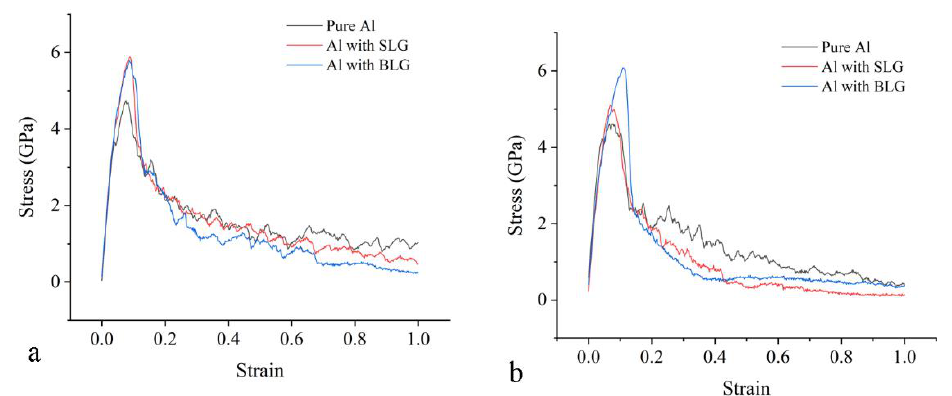
Figure 6. The atomic details of SLG in the tensile process. ( a ) SLG in sintered structure before stretching; the stress distribution in SLG under maximum stress stretched in the y axis ( b ) and z axis ( c ). The networks on the left represent graphene, and the balls on the right represent adjacent Al atoms, which are colored by per-atom stress (unit: bar × Angstrom 3 ).